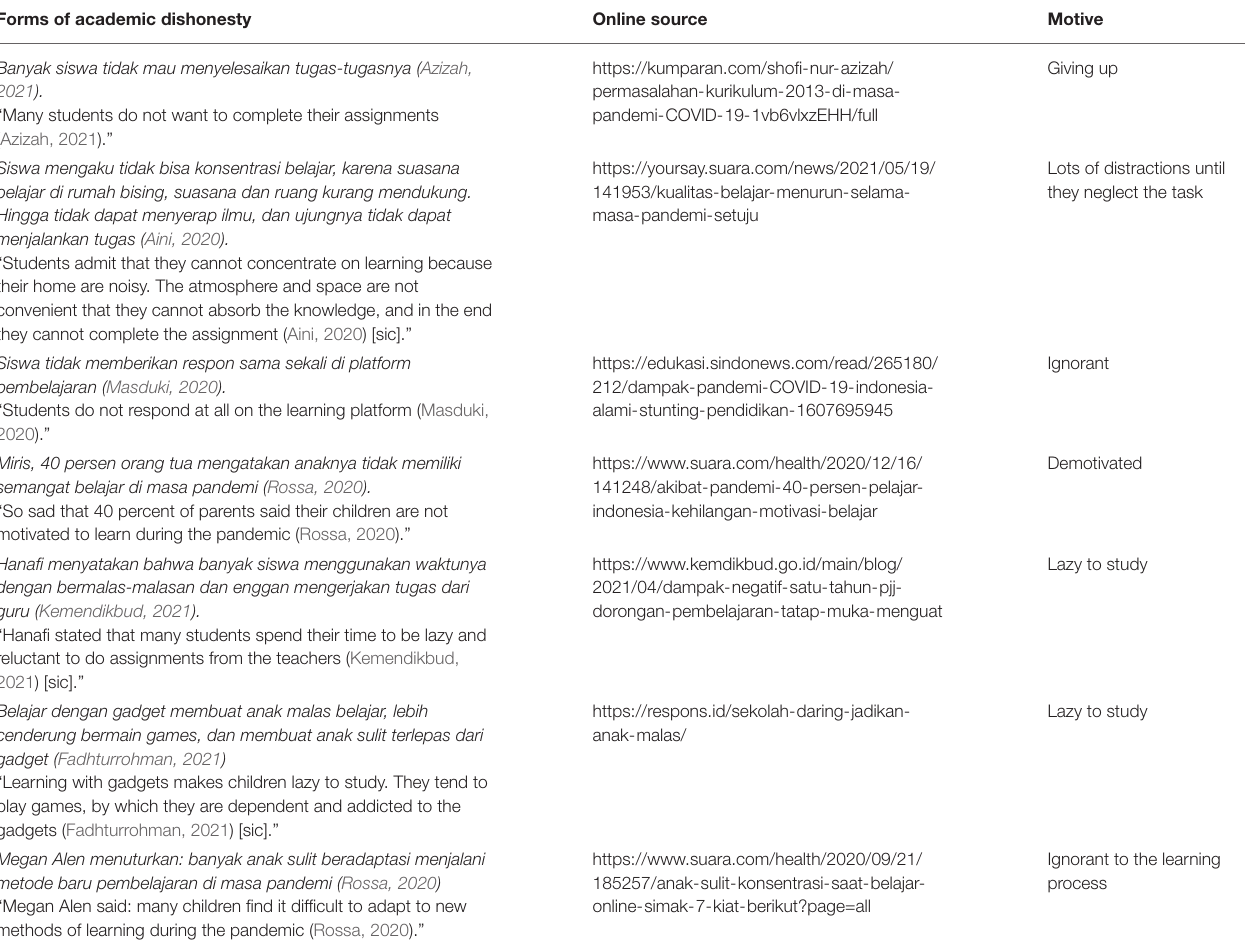
TABLE 4 | The loss of students’